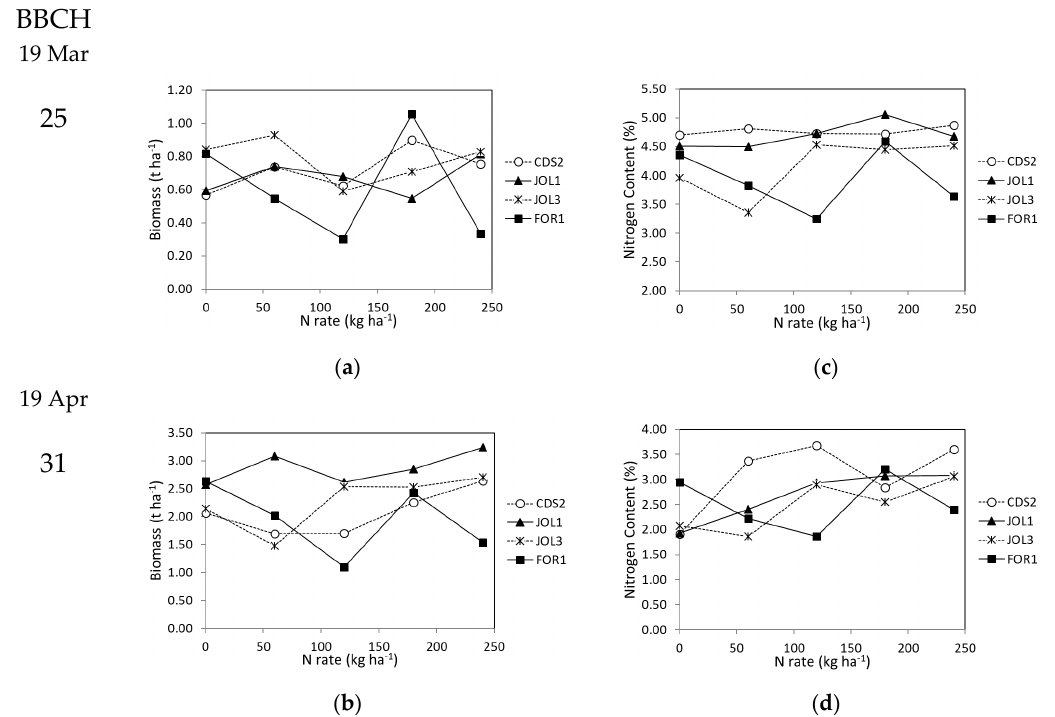
Figure 3. Response of wheat above ground biomass (W) and Na% to N fertilizer rates, measured during the 2019 field campaigns in the different soil classes (see Table 5): ( a ) W at 19 Mar BBCH 25; ( b ) W at 19 Apr BBCH 31; ( c ) Na% at 19 Mar BBCH 25; ( d ) Na% at 19 Apr BBCH 31.